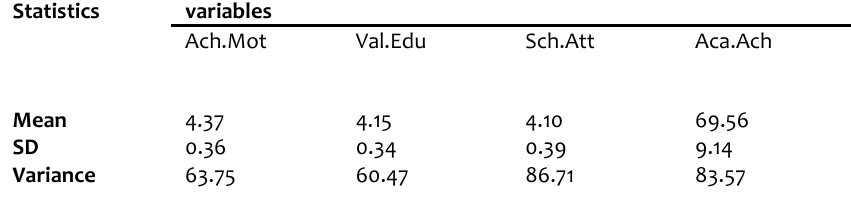
Table ‐ 2: Descriptive statistics of the variables considered in the study. (N=362)